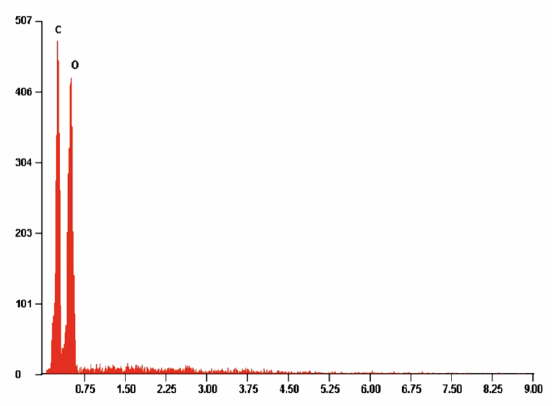
Figure 7. Example of the energy-dispersive X-ray spectroscopy (EDS) spectrum of PLA nonwoven fabric.